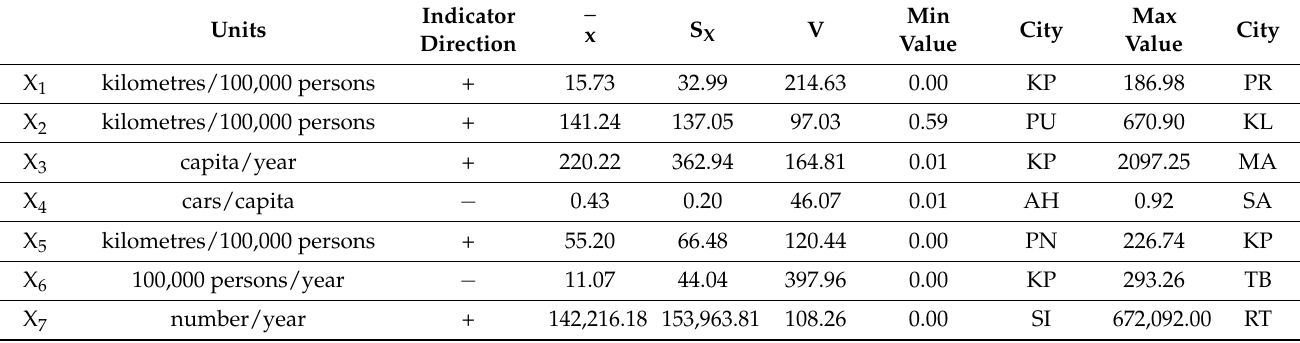
Table 4. Basic statistics of urban transport indicators.